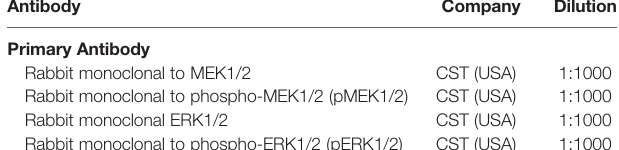
TABLE 2 | Antibodies. Antibody Company Dilution Primary Antibody Rabbit monoclonal to MEK1/2